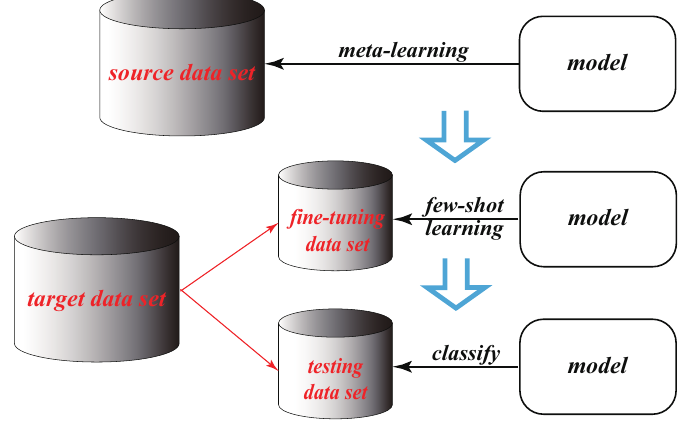
Figure 1. Definition of few-shot